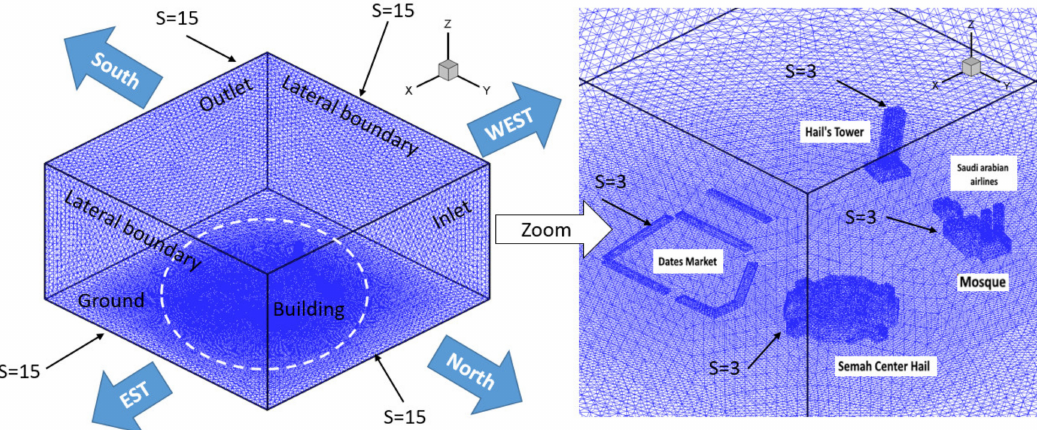
Figure 3. Mesh and boundaries conditions.